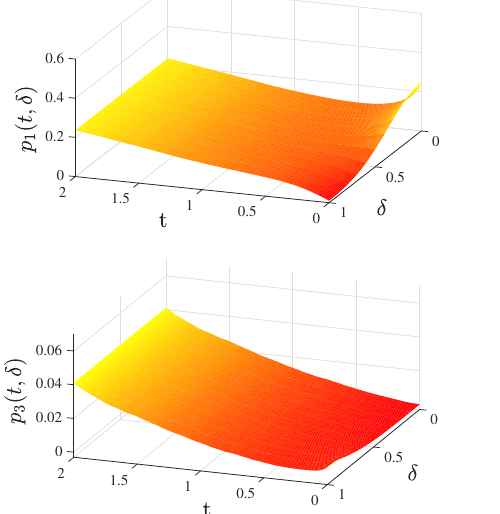
Figure 3. The state trajectories of the system (20) without controller.